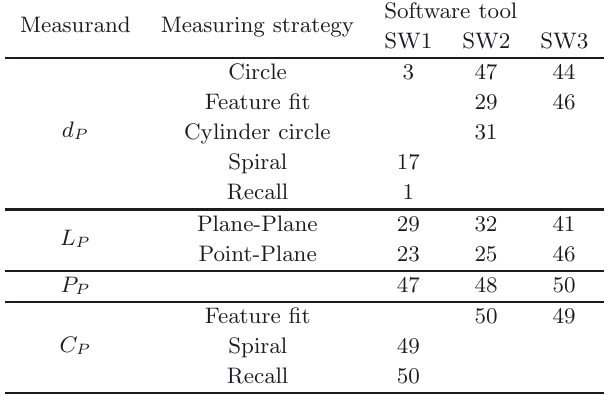
Table 4. Bias contribution to the measurement uncertainty ( | b | /U CT in %) calculated for the pipe connector.